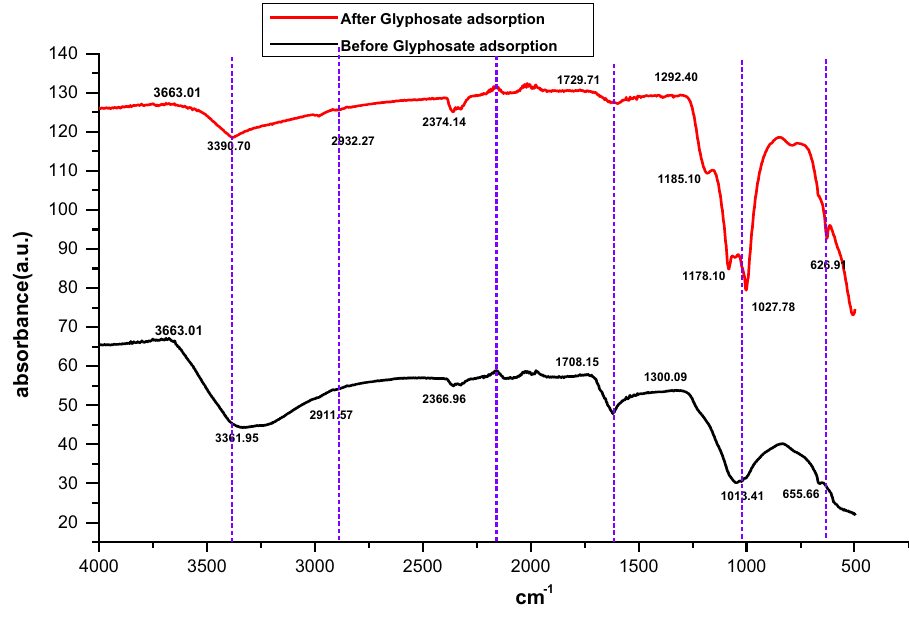
Fig. 1 FTIR study before (black line) and after (red line) adsorp- tion of glyphosate on